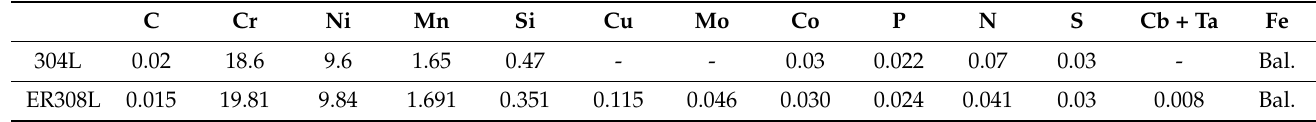
Table 1. Chemical composition of 304L stainless steel and filler metal (wt%) (Reprinted with permis- sion from [36]. 2022, MDPI).).